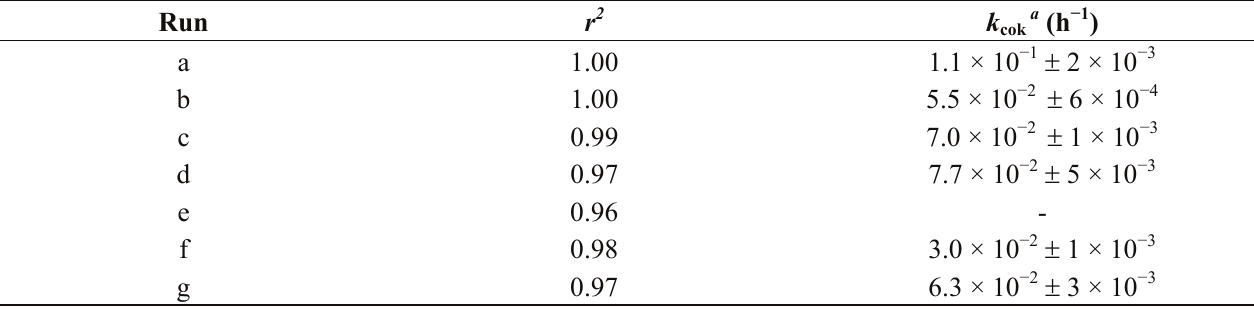
Table 2. Deactivation kinetic constants for